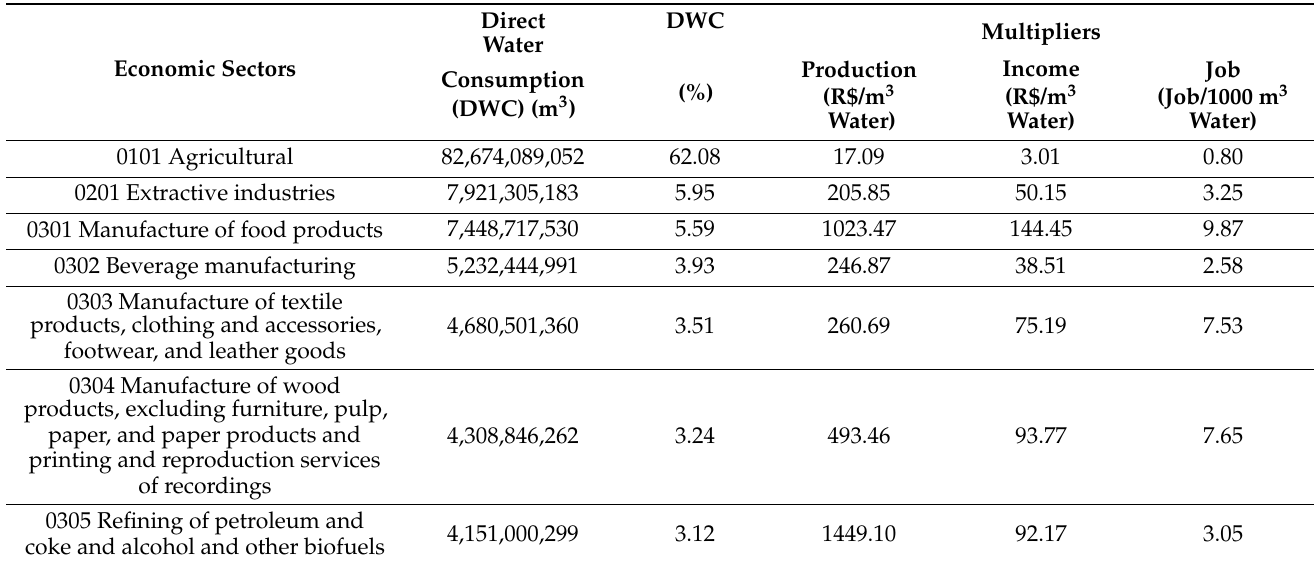
Table A1. Direct water consumption, and sector multipliers of production, income, and employment in terms of water flows.